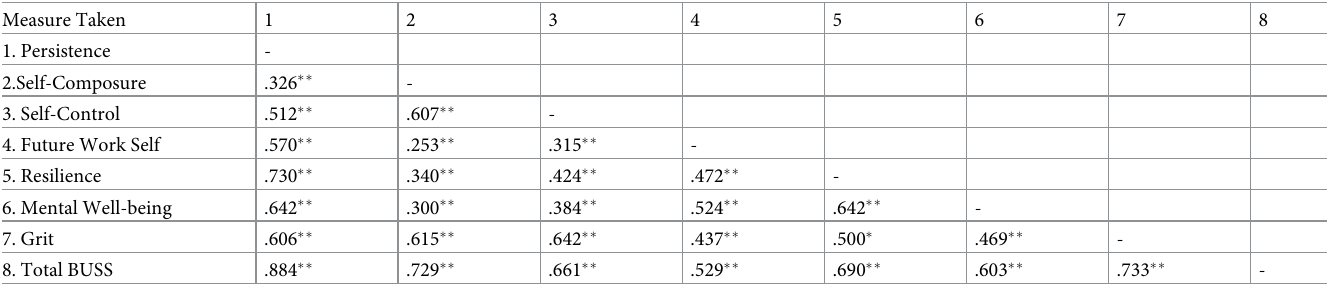
Table 4. Correlation between persistence, self-composure and other measures